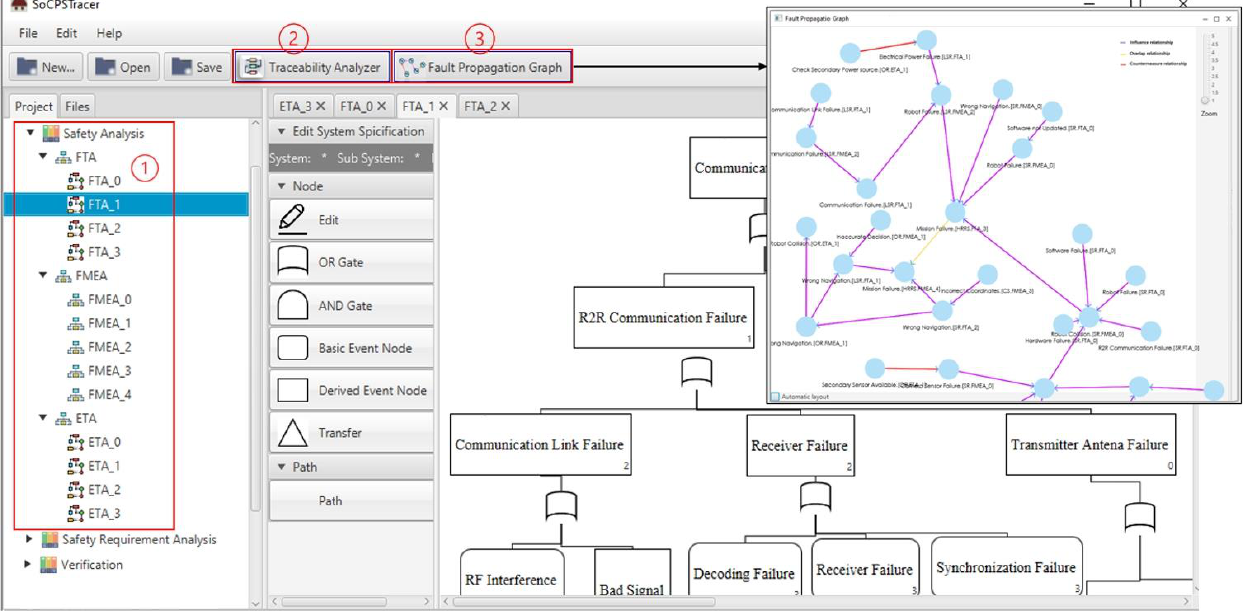
Figure 4. SoCPSTracer Tool View .